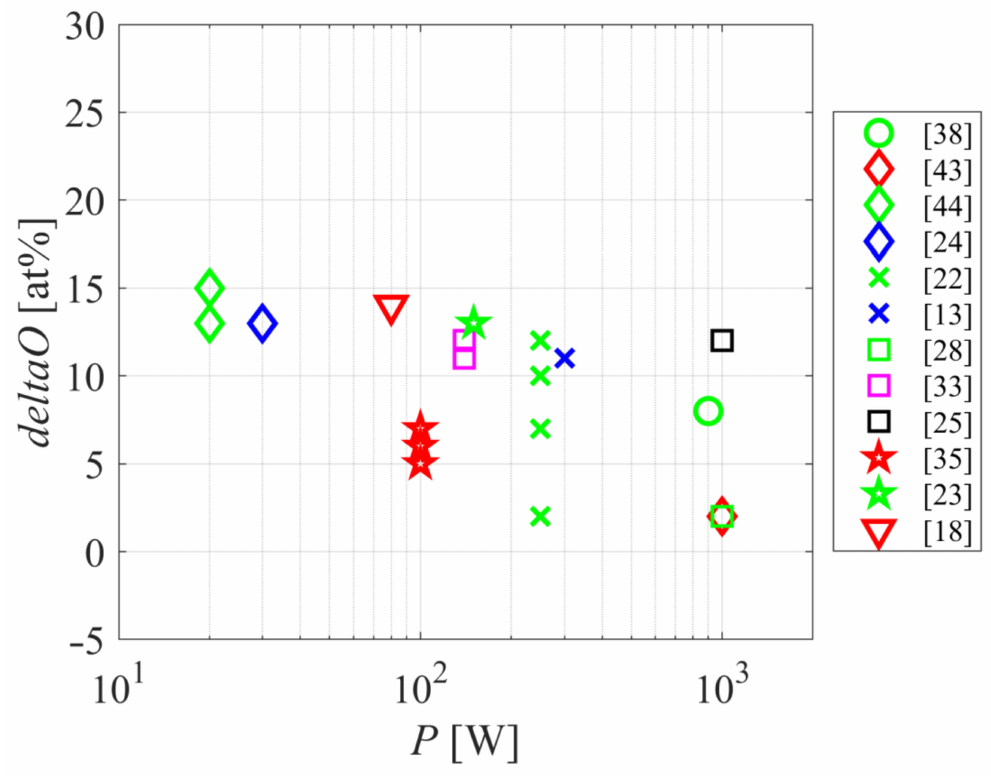
Figure 7. The di ff erence in oxygen concentration as probed by XPS versus the discharge